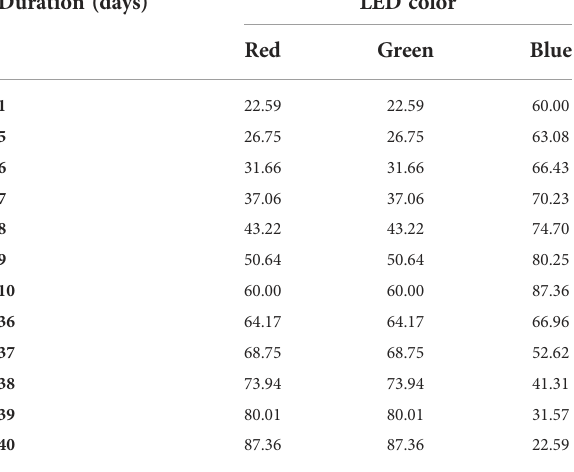
TABLE 4 LED duty cycle change for duration of the